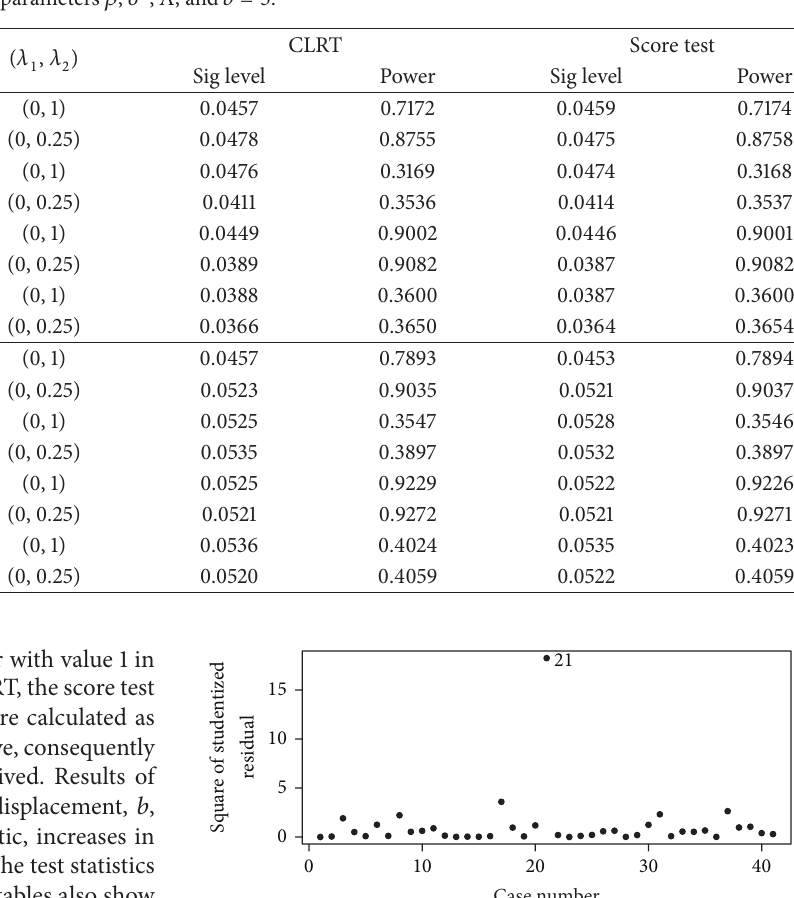
Figure 1: Plot of square of the studentized residual (𝑡 2 𝑖 ) versus case number.